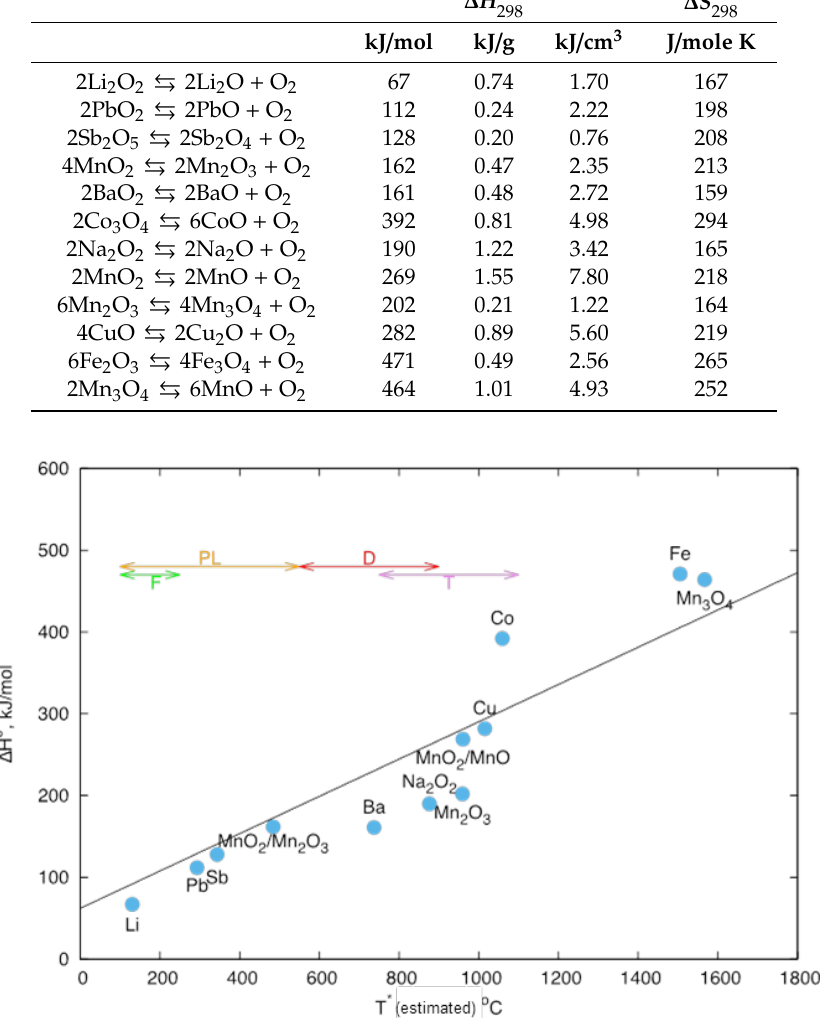
Figure 6. Heat of reaction vs. estimated turning temperature for different metal oxides systems, with indication of the operating temperature ranges for the main Concentrated Solar Thermal technologies: Fresnel (F), Parabolic trough (PL), Dish (D), Solar Tower (T). Table 1. Heat and entropy of reaction for the most relevant metal oxide systems from [30–35].